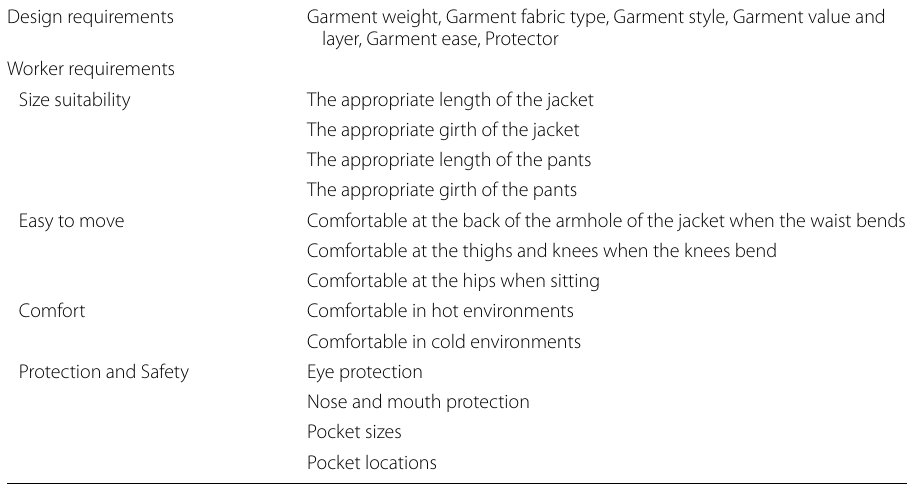
Table 12 Integration of workers’ requirements and design requirement suggestions Design requirements Worker